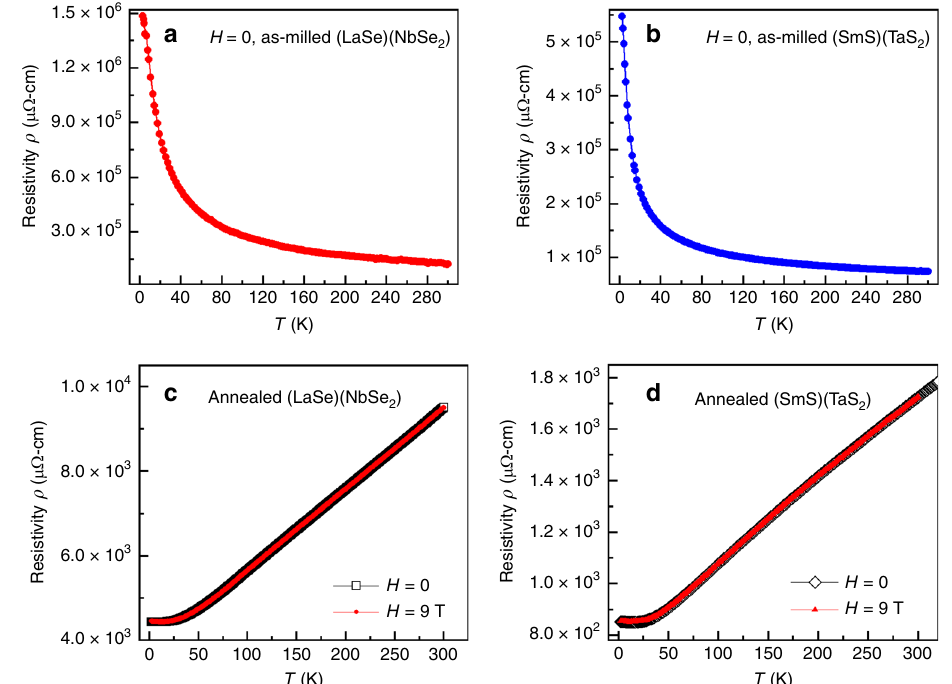
Fig. 8 Electrical resistivity characterization of heterostructures. a Electrical resistivity versus temperature measured in 0 and 9 T fi elds for as-milled and c annealed (LaSe)(NbSe 2 ); b as-milled and d annealed (SmS)(TaS 2